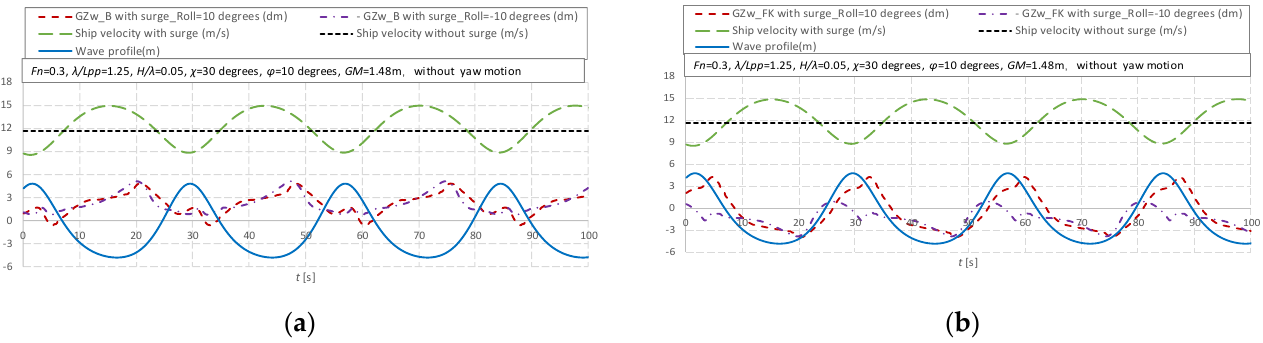
Figure 5. The comparison of the roll-restoring variation at the starboard and port with φ = 10, −1 0 degrees, ( a ) GZ W _B ; ( b ) GZ W _FK only.